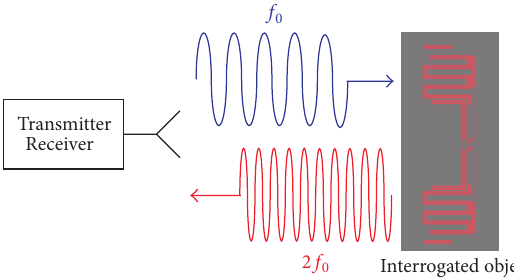
Figure 1: Illustration of the harmonic radar concept. Here, the second harmonic frequency 2𝑓 0 is used for